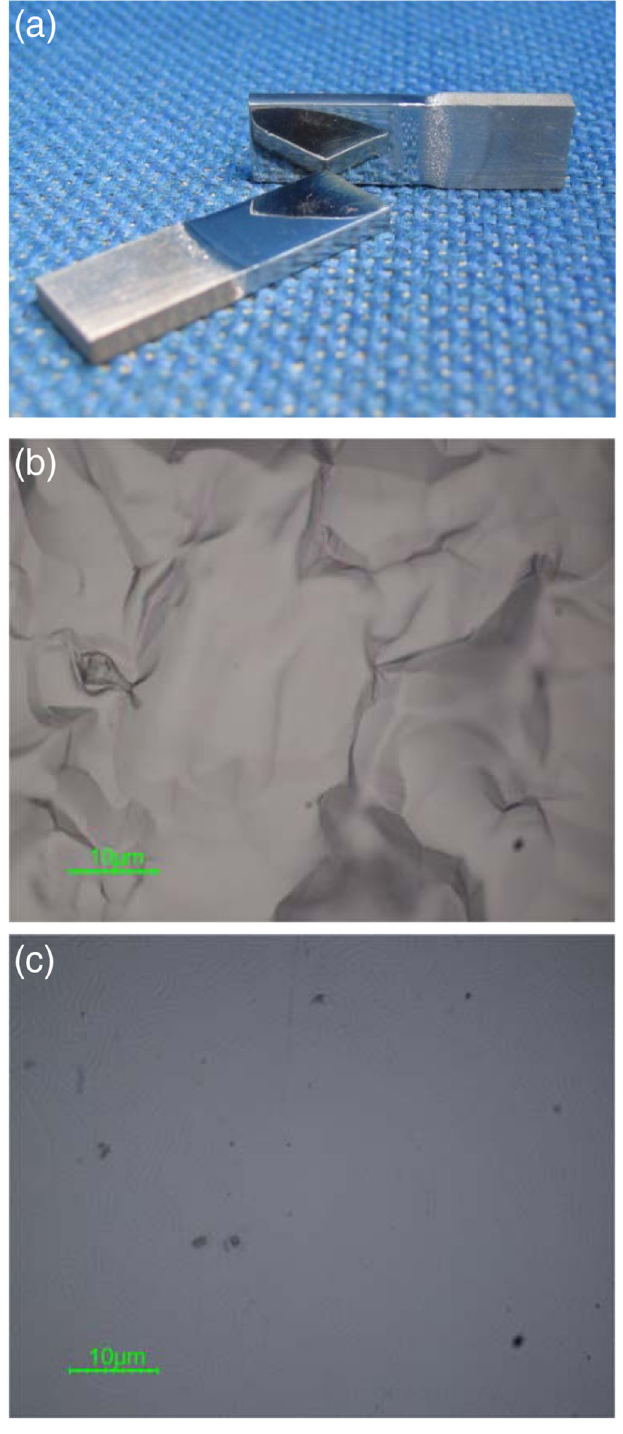
FIG. 9. (Color) CCD images of niobium sheet surface. (a) Photo of the Nb samples treated by BEP. (b) Typical fine grain Nb surface after BCP treated as viewed by metallographic optical microscope (MOM). (c) Typical MOM image of BEP treated Nb surface.